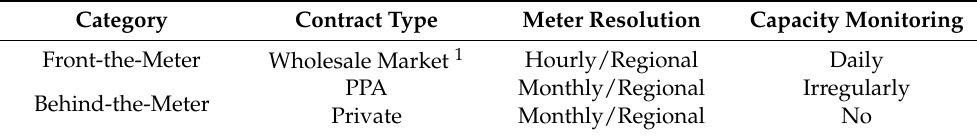
Table 3. Classification of Distribution Energy Resources Based on Contract Type and Visibility.